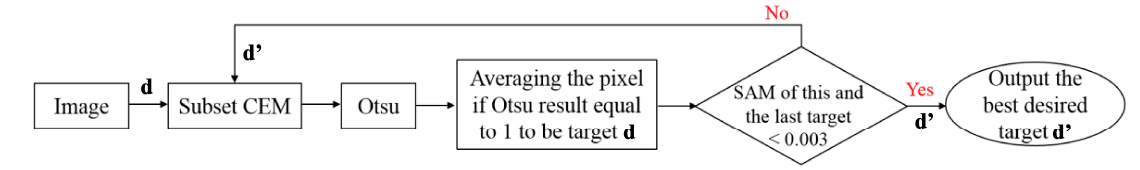
Figure 8. Flowchart of Optimal Signature Generation Process (OSGP).